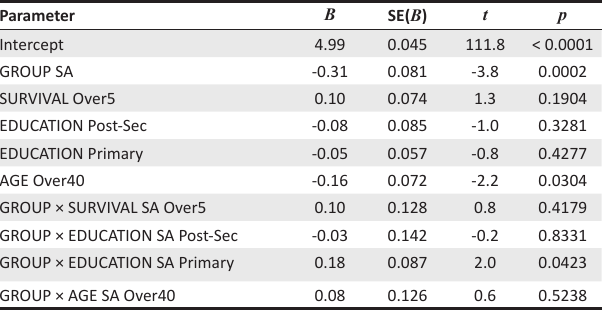
TABLE 10: Parameter estimates for two-way interaction analysis of variance model of use of customer service and pricing.